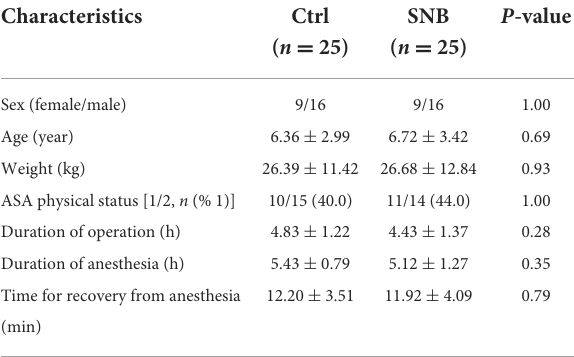
TABLE 1 Demographic characteristics of group Ctrl and group SNB. TABLE 2 Pain scores across postoperative time